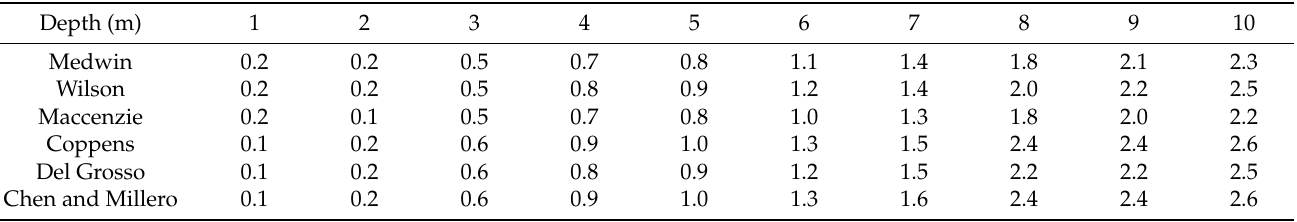
Figure 8. Temperature, salinity and sound speed in water profiles in the Martwa Wisła River. Table 8 shows the depth error as a difference between the depth determined using vertical distribution of the sound speed and on the basis of the simplified method with constant salinity S = 6 psu in the Martwa Wisła River. In the depth range of 0–10 m, the difference is no more than 2.5 cm. Table 8. Depth measurement error (cm) for selected formulas according to MTPS (S = 6 psu) in the Martwa Wisła